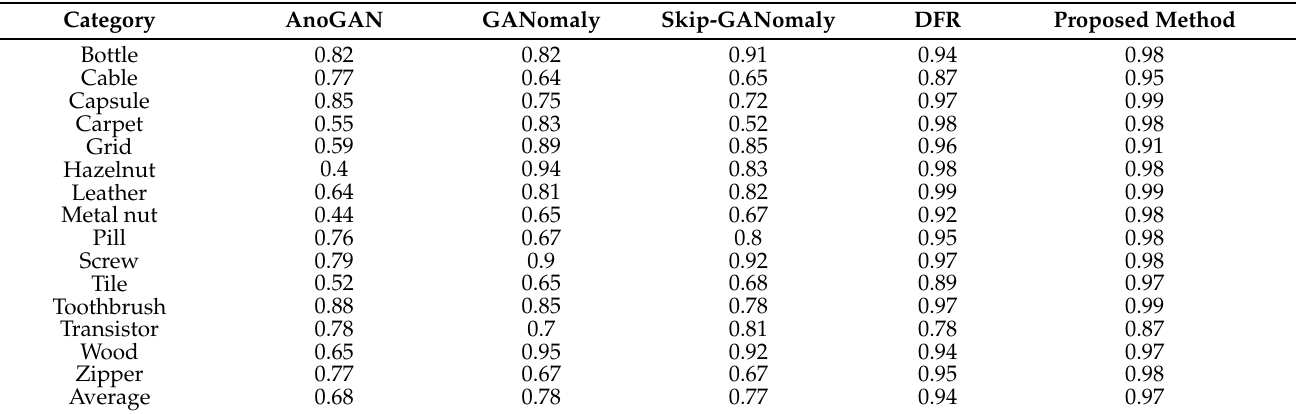
Figure 4. Segmented masks and heat maps of each category created using the proposed method. Table 2. AUCs of MVTec AD dataset using AnoGAN, GANomaly, Skip-GANomaly, and the pro- posed method.